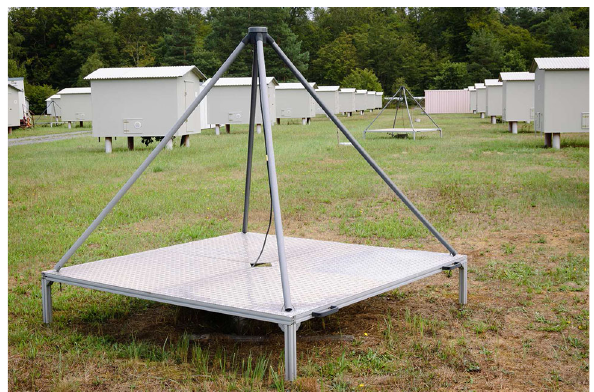
Fig. 1 Photo of an inverted v-shape dipole antenna of the LOPES-30 setup in the KASCADE particle-detector array